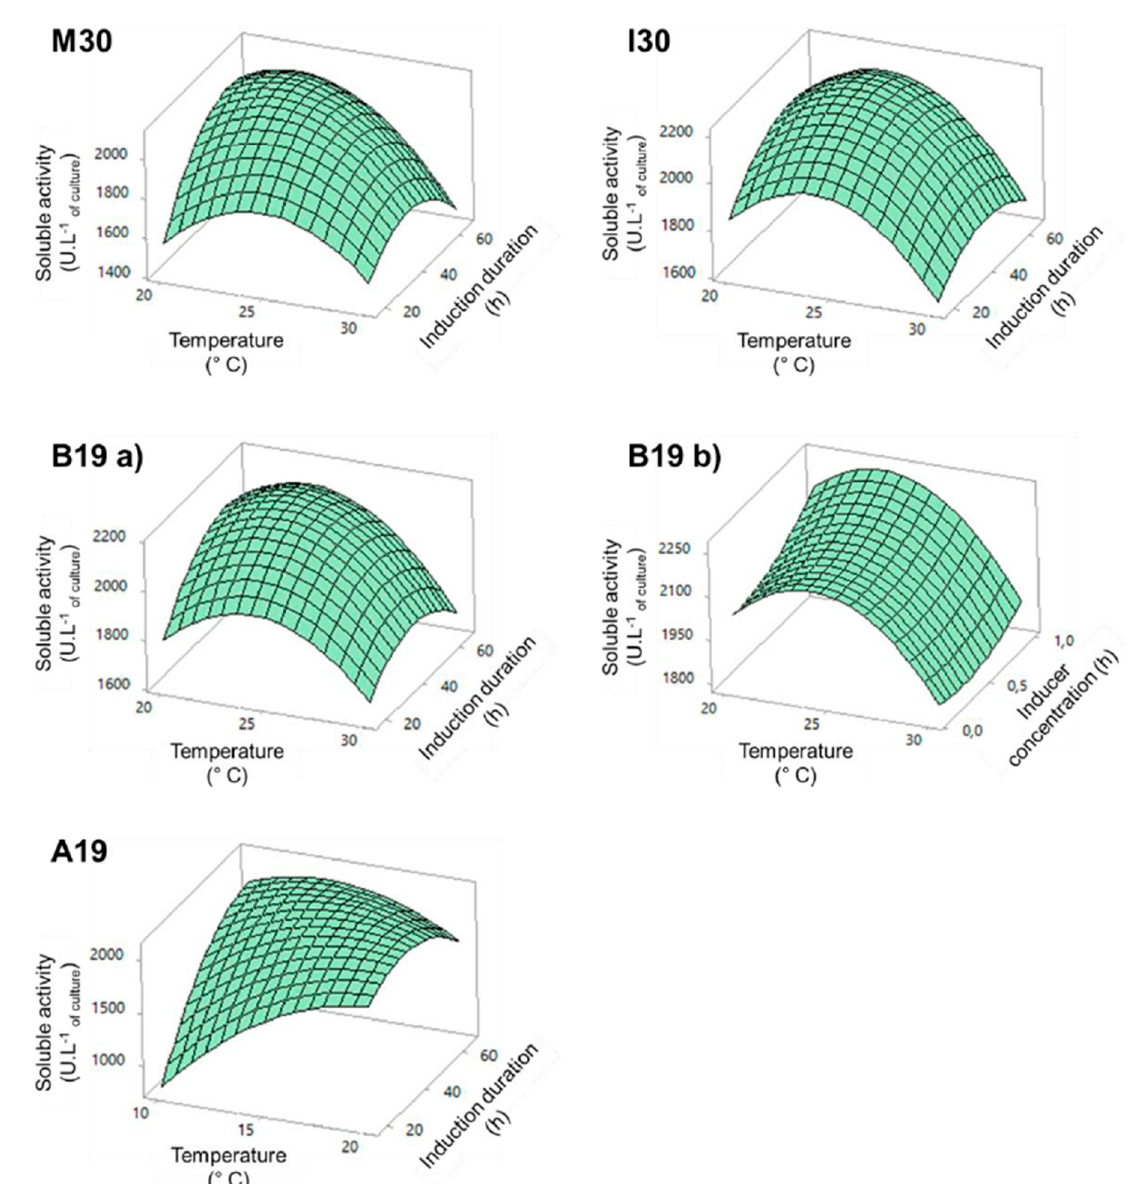
Figure 2. Three-dimensional (3D) response surface plots of the HPL activity recovered in the soluble fraction for M30 and I30 expression systems, as a function of the temperature and induction duration; for B19 expression system, as a function of ( a ) temperature and induction duration and ( b ) temperature and inducer concentration; and for A19 expression system.